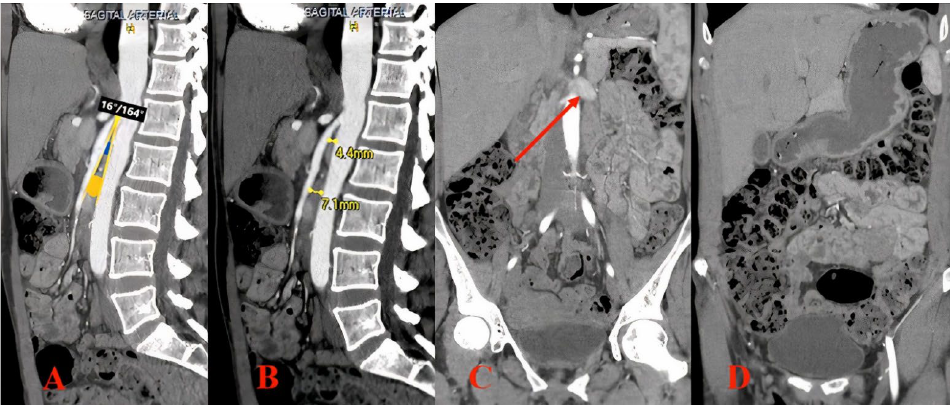
Figure 2. Computed tomography (CT) angiography findings. ( A ) Sagittal view revealing an aortomesenteric angle of 16 degrees; the blue circle represents the left renal vein and the yellow circle represents the location of the terminal duodenum. ( B ) Sagittal view revealing an aortomesenteric distance of 4.4 mm at the renal vein level and 7.1 mm at the duodenum level. ( C ) Coronal view showing a dilated left renal vein (arrow). ( D ) Coronal view showing an important distention of the stomach, with gastric stasis and gas distension of intestines. Notably, a tumor growth was described in the right ovary, possibly a hypertrophic corpus luteum, with a gynecological recommendation for periodic follow-up. Selective left renal vein angiography was further performed and revealed the ob- struction at the junction of the LRV with the inferior cava. Since the patient refused all surgical options, the interventional strategy consisting of LRV stenting was planned for the same procedure, with the aim of not only restoring normal LRV flow but also correct- ing the aortomesenteric angle, thereby reducing the compression of the duodenum. Bilat- eral femoral vein access was obtained and two wires were crossed in the LRV (a diagnostic super stiff Amplatz wire from the right and a coronary BMW wire from the left, as land- mark). A balloon expandable stent measuring 9/40 mm was implanted at the obstruction site, but the stent migrated towards the renal side of the vein when post-dilation was tented. At this point, the guide catheter was replaced with a long-armed sheath and the stent lumen was recrossed with a super stiff wire, managing to retrieve the stent at the ostium vessel with a partially inflated balloon. Post-dilation was attempted once more, but, due to the trend towards migration, the procedure was aborted. As a post-procedural vascular ultrasound showed partial migration of the stent toward the left kidney and the patient complained of persistent flank pain, a second procedure was planned the next day, using the jugular vein as the access site, with the aim of repositioning the stent and thus optimizing the result. Echo-guided access to the jugular vein was obtained and the stent lumen was crossed with a super stiff wire. A 10/30 mm balloon was advanced into the stent, with 5 mm protrusion distally to the stent. After partial inflation of the balloon, the retraction of the stent at the lesion site was possible and a complete inflation at 16 atmos- pheres was performed, with a good apposition to the vessel wall being obtained, but with important deformation of the distal struts of the stent. As a result, a second balloon ex- pandable to 9/60 mm was implanted at the ostium, which partially overlapped with the previous stent, and post-dilations with a 10/30 mm balloon were performed along the en- tire length of the stents. Final post-dilatation at the ostium was performed with a 12/40 mm balloon, with a good final angiographic result and a good and stable apposition being obtained, as the compression of the vein was no longer visualized. Figures 3 and 4 illus- trate the main steps of the endovascular procedures.